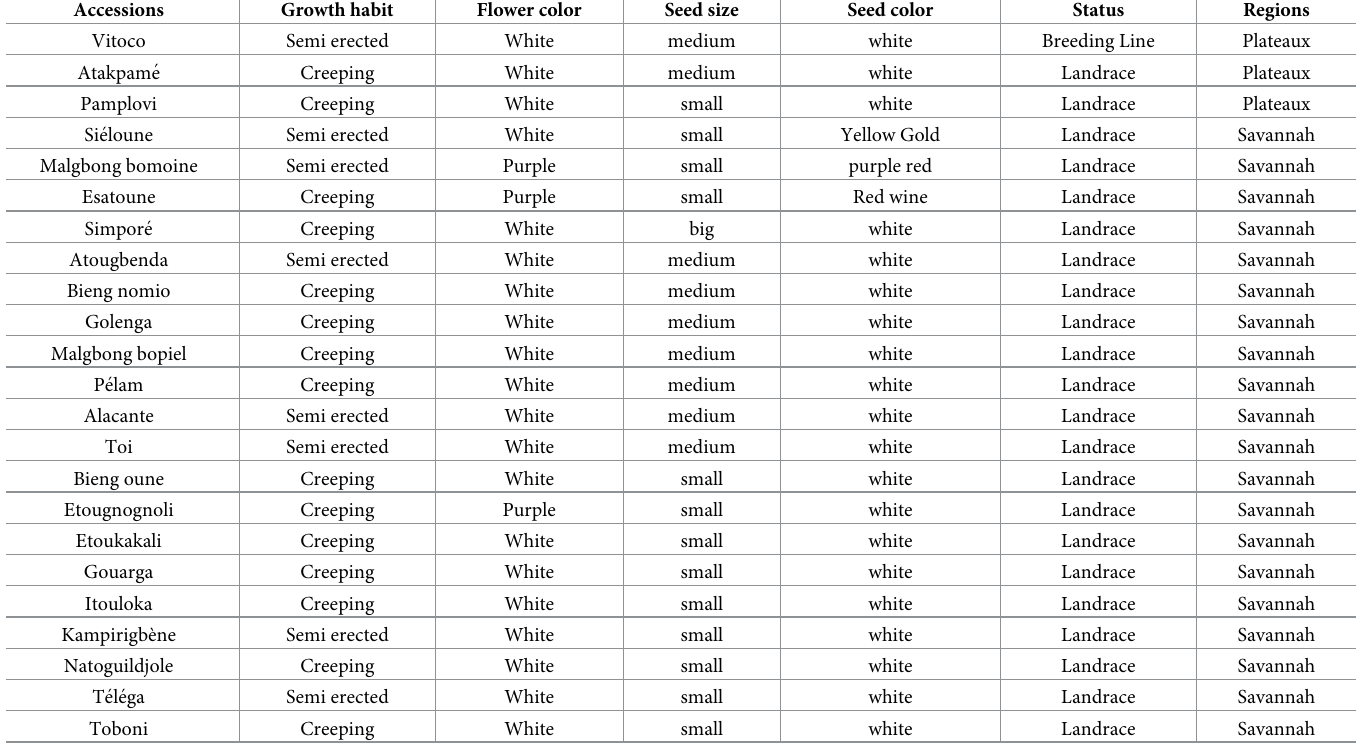
(I = -1 � ∑ ( Pi � Ln (pi))), observed heterozygosity (Ho = number of heterozygotes/number of genotypes (N)), gene diversity (He = 1 (cid:0)